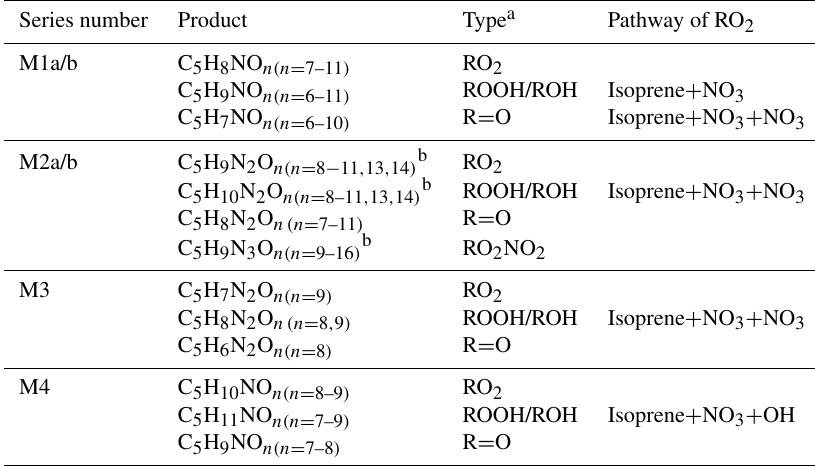
Figure 1. Mass spectrum of the HOM formed in the oxidation of isoprene by NO 3 . HOM are detected as clusters with the reagent ion 15 NO − , which is not shown in the molecular formula in the figure for simplicity. Panels (a) and (b) show the average spectrum during the 3 first isoprene addition period (P1) and for the whole period of six isoprene additions (P1–6), respectively. The insets show the contributions of different classes of HOM. 1–3N-monomer refers to the monomers containing one to three nitrogen atoms in the molecular formula. Table 1. HOM monomers formed in the oxidation of isoprene by NO 3